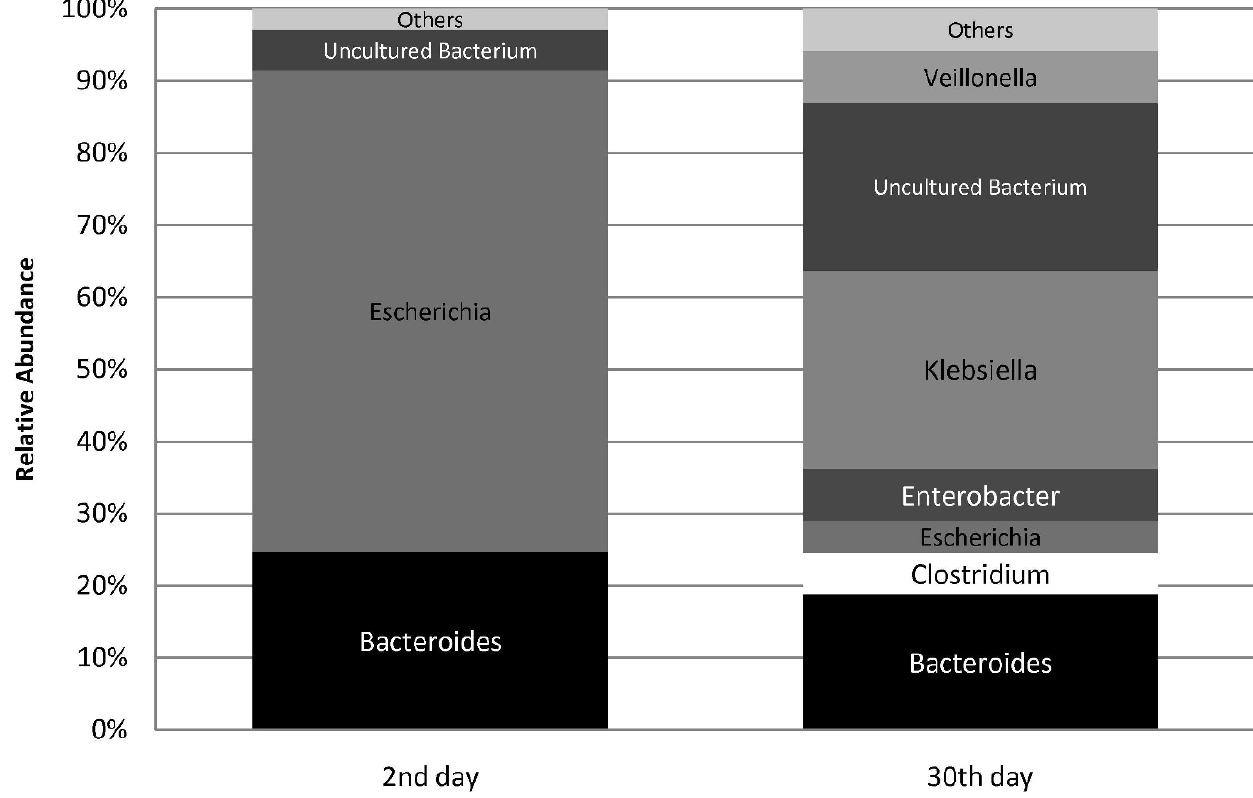
Figure 2 - Bacterial profile of the 16S rRNA library constructed with fecal samples from one child who used an oral antibiotic for 10 days. The sequences were grouped into genera. The data are shown per time